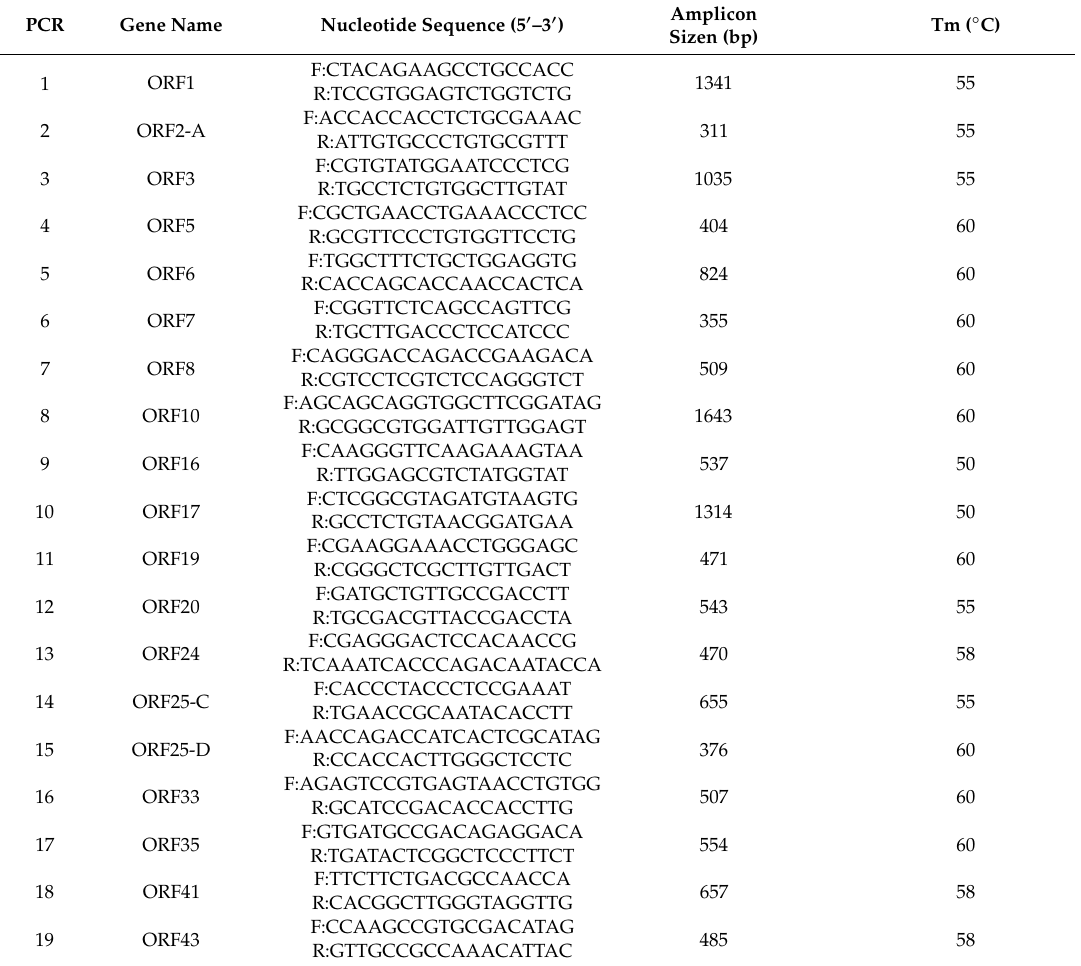
Table 1. Oligonucleotide primers and conditions for PCR and Real-time